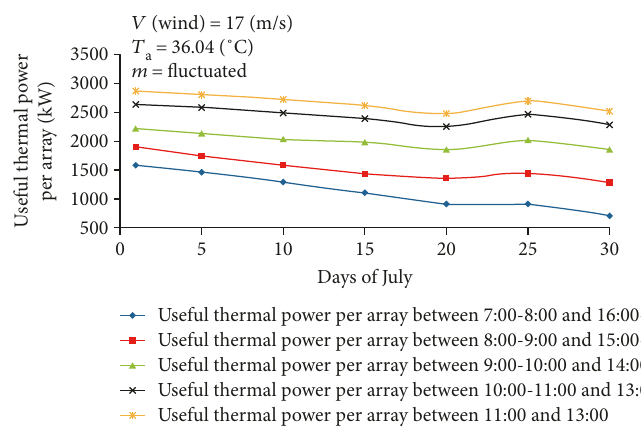
Figure 8: Useful thermal power per array for July.